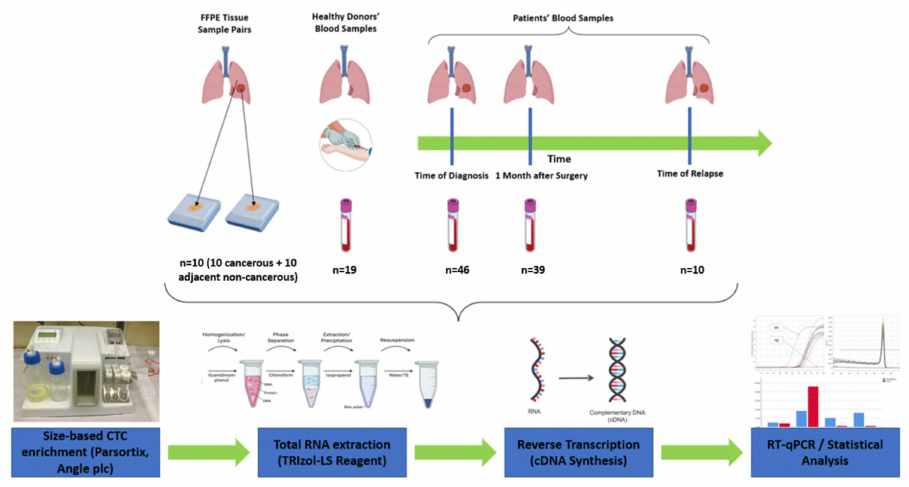
Figure 1. Outline of the experimental procedure.